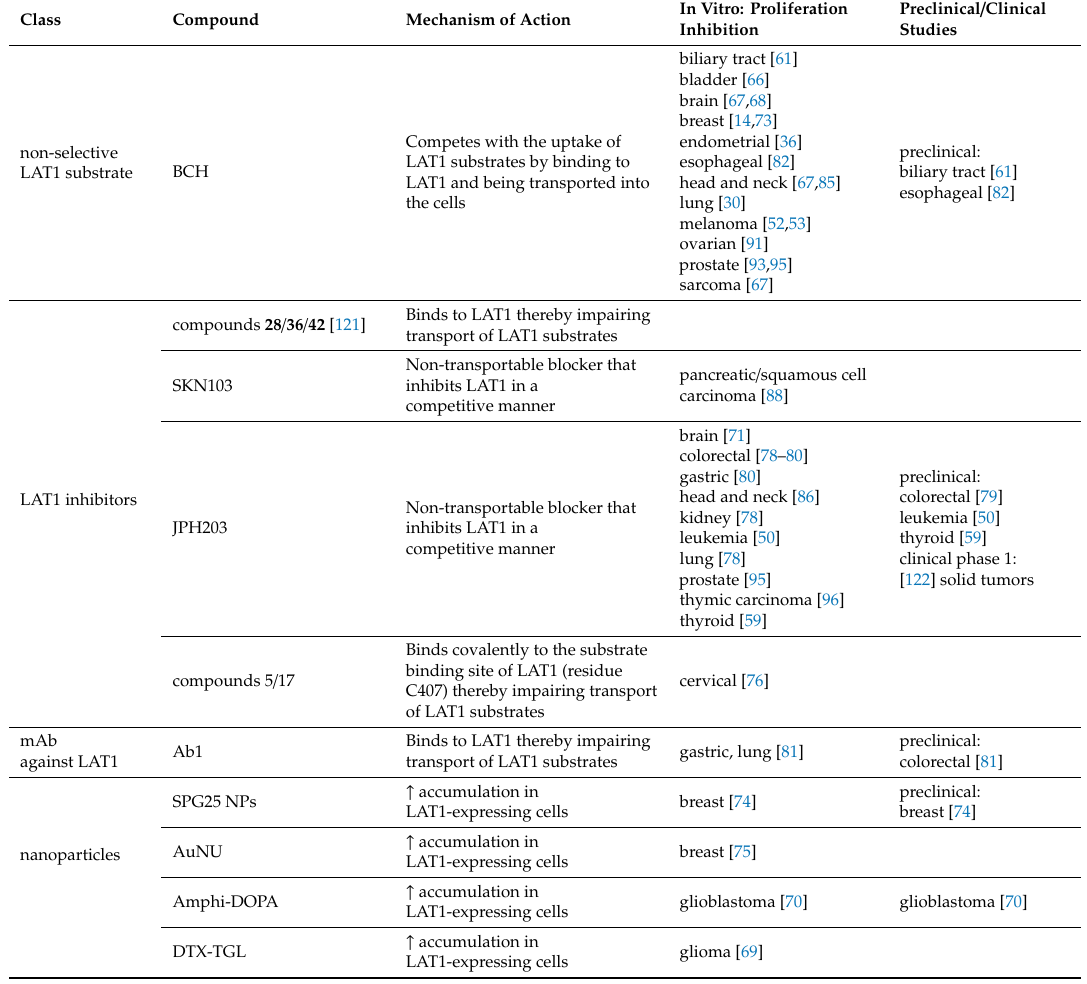
Table 2. Current LAT1-targeting